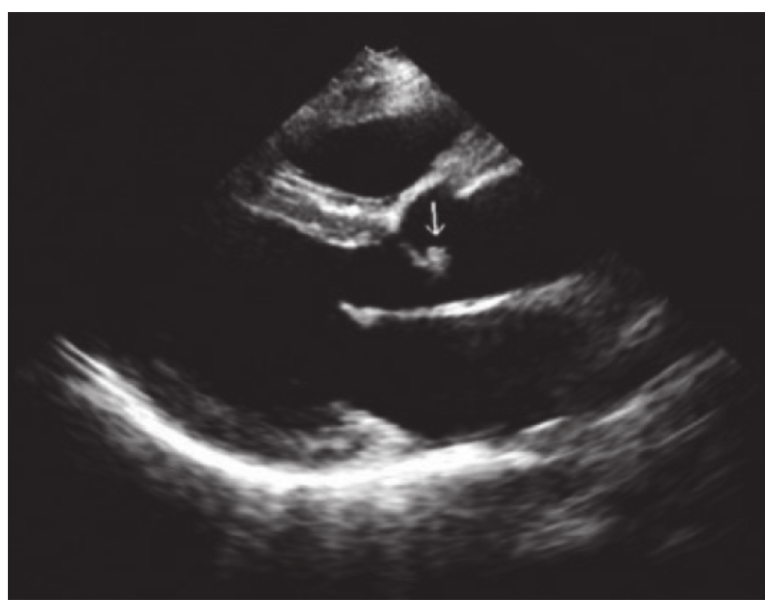
Figure 3: Transthoracic echocardiogram demonstrated the vegetation locating in the aortic valve (white arrow).